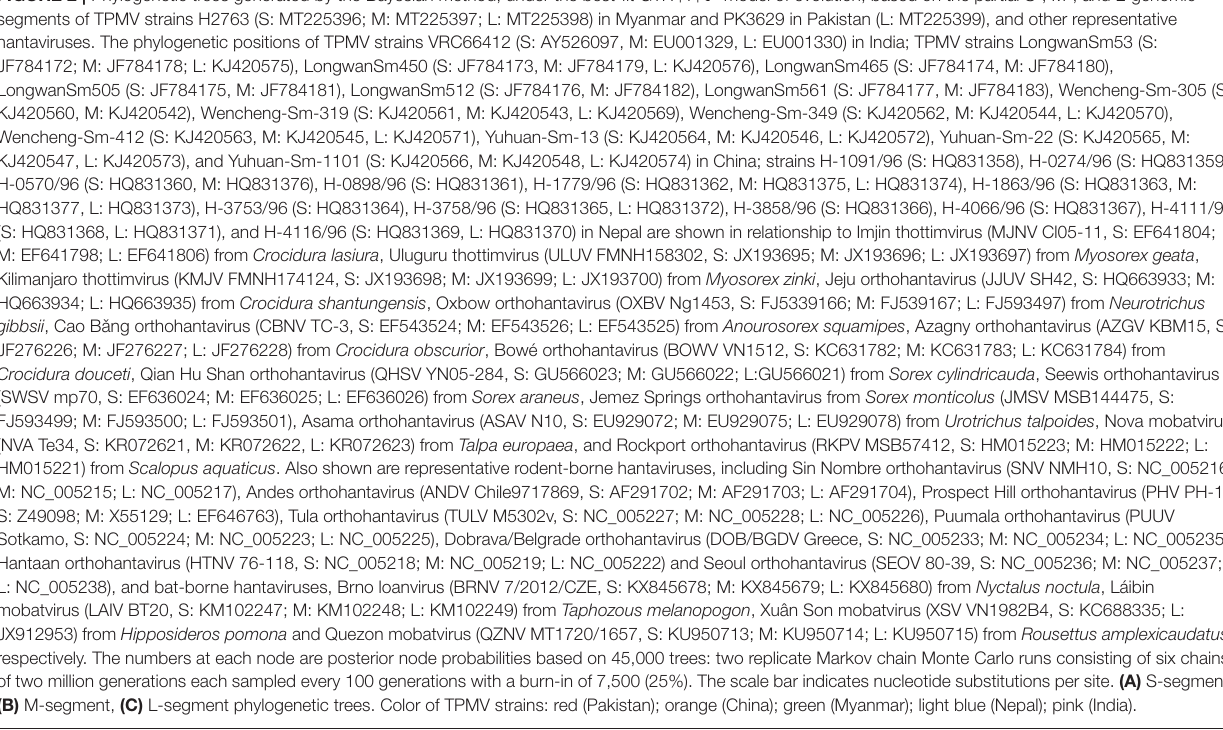
Frontiers in Cellular and Infection Microbiology | www.frontiersin.org